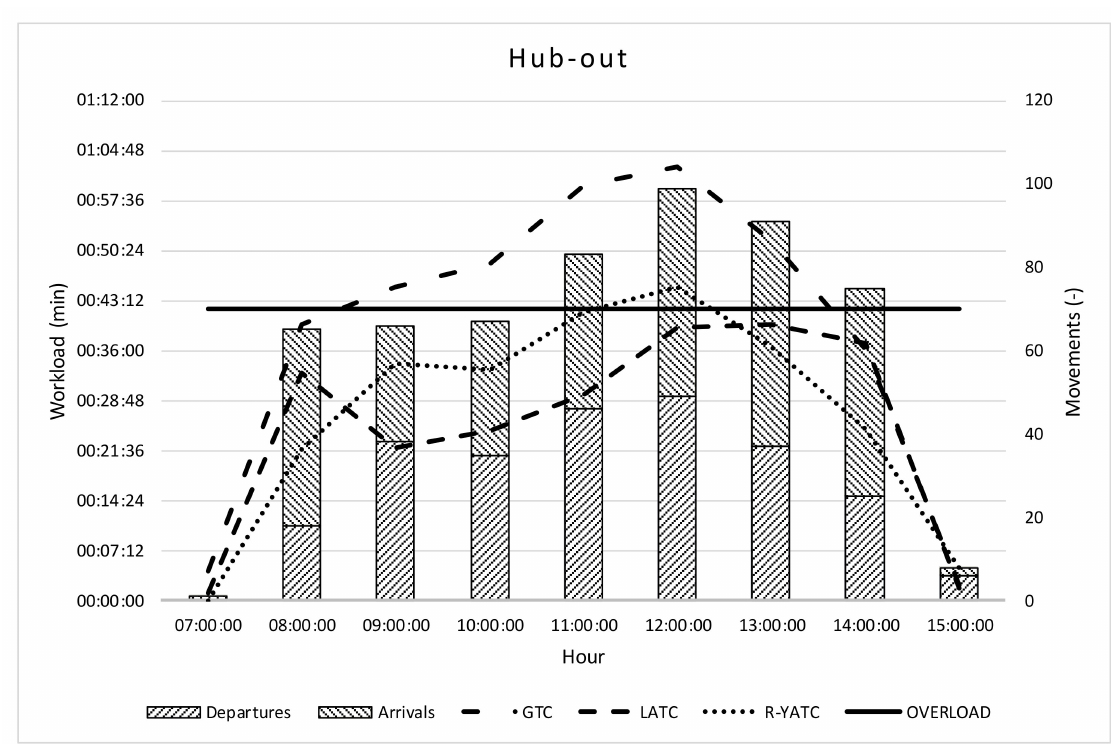
Figure 5. Hub-out workload and